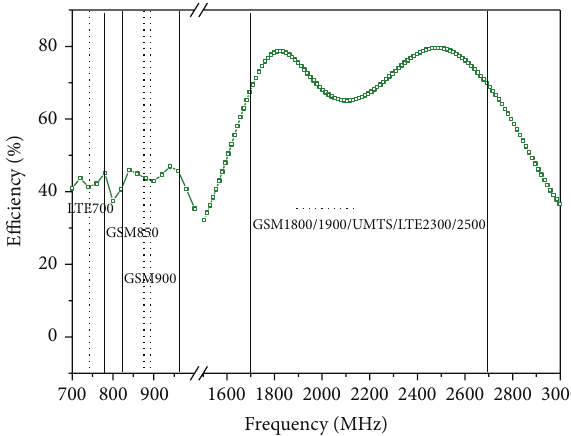
Figure 6: Measured antenna efficiencies (mismatching losses included) against frequency for the proposed